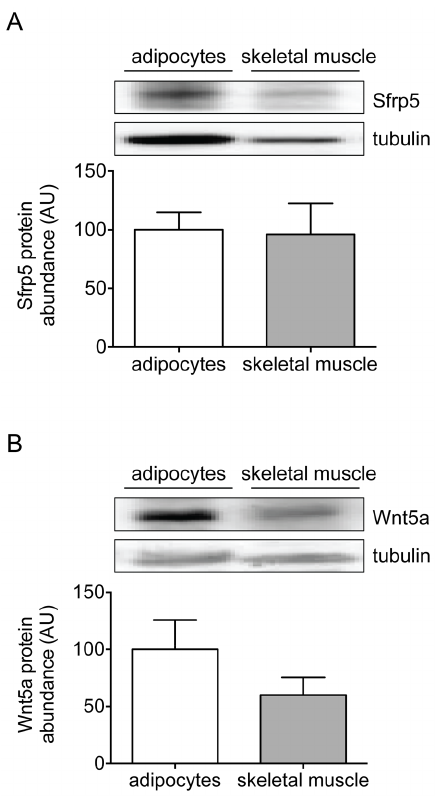
Figure 7. Protein levels of Sfrp5 and Wnt5a in primary human adipocytes and skeletal muscle cells. Lysates from differentiated primary human adipocytes and skeletal muscle cells were analyzed for protein abundance of Sfrp5 (A) and Wnt5a (B) by Western blotting. Phosphorylation signals were normalized for GAPDH protein abun- dance and expressed as mean 6 standard error of the mean of independent experiments (adipocytes; n=6; skeletal muscle: n=4) using cells from different donors. The values obtained for adipocytes were set at 100%.